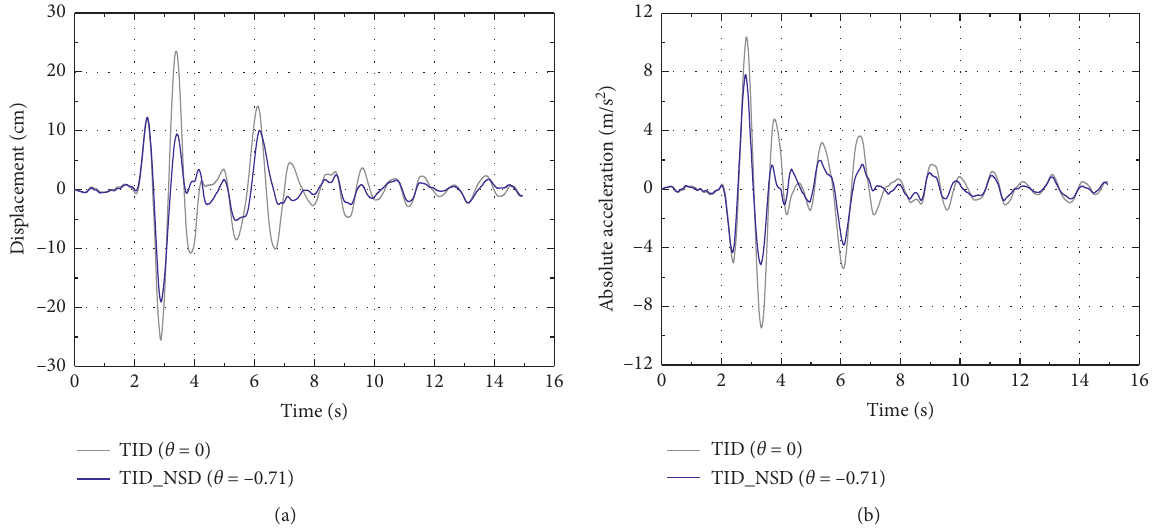
Figure 5: Time history response of the primary system under earthquake record LA16. (a) Maximum displacement. (b) Maximum absolute